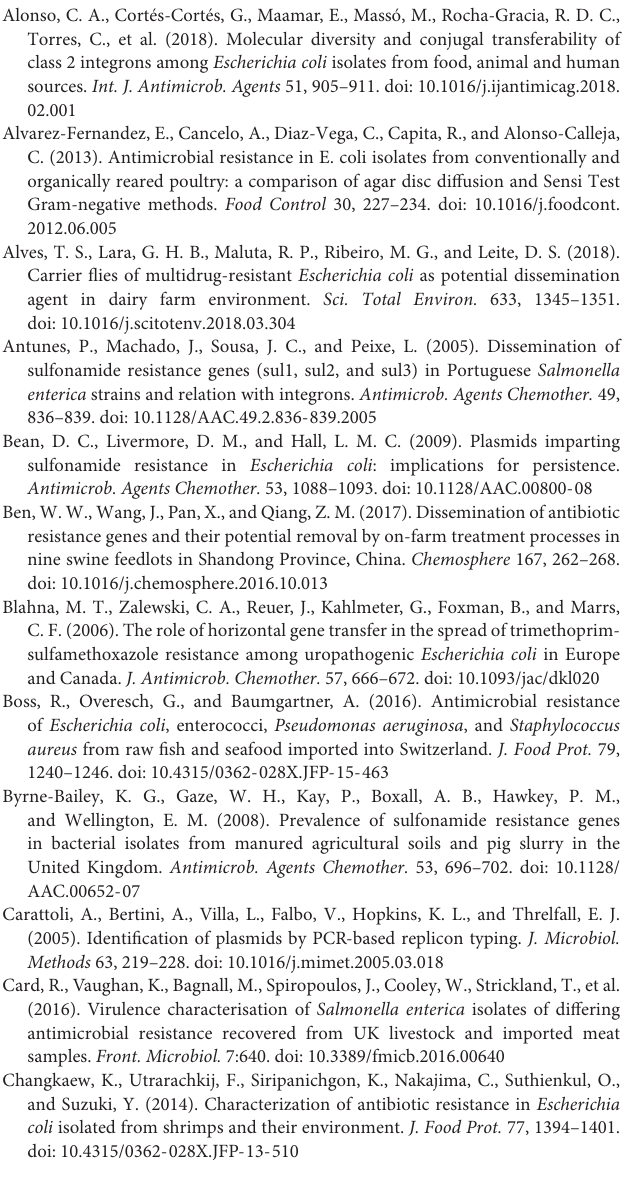
isolate; 2, chromosomal DNA of 1PO-27 isolate; 3, chromosomal DNA of 2PO- 11 isolate; 4, chromosomal DNA of 3PV-24 isolate; 5, chromosomal DNA of 2PV-02 isolate; 6, chromosomal DNA of 1PV-44 isolate. M, DNA molecular weight marker II, digoxigenin-labeled (Roche, Penzberg, Germany) with the following base pair lengths: 125, 564, 2027, 2322, 4361, 6557, 9416, and 23,130 bp. FIGURE S3 | Primary PCR products of sul gene flanking sequences obtained using the PCR walking method. (A) Products of sul1 gene flanking sequences. (B) Products of sul2 gene flanking sequences. (C) Products of sul3 gene flanking sequences. M: DL5000 marker (100, 250, 500, 750, 1000, 2000, 3000, and 5000 bp). 1 − 7, products of sul gene upstream sequences (DNA template is Dra I library, Eco RV library, Hpa I library, Pvu II library, Sma I library, Stu I library, and Ssp I library). 8 − 14, products of sul gene downstream sequences (DNA template is Dra I library, Eco RV library, Hpa I library, Pvu II library, Sma I library, Stu I library, and Ssp I